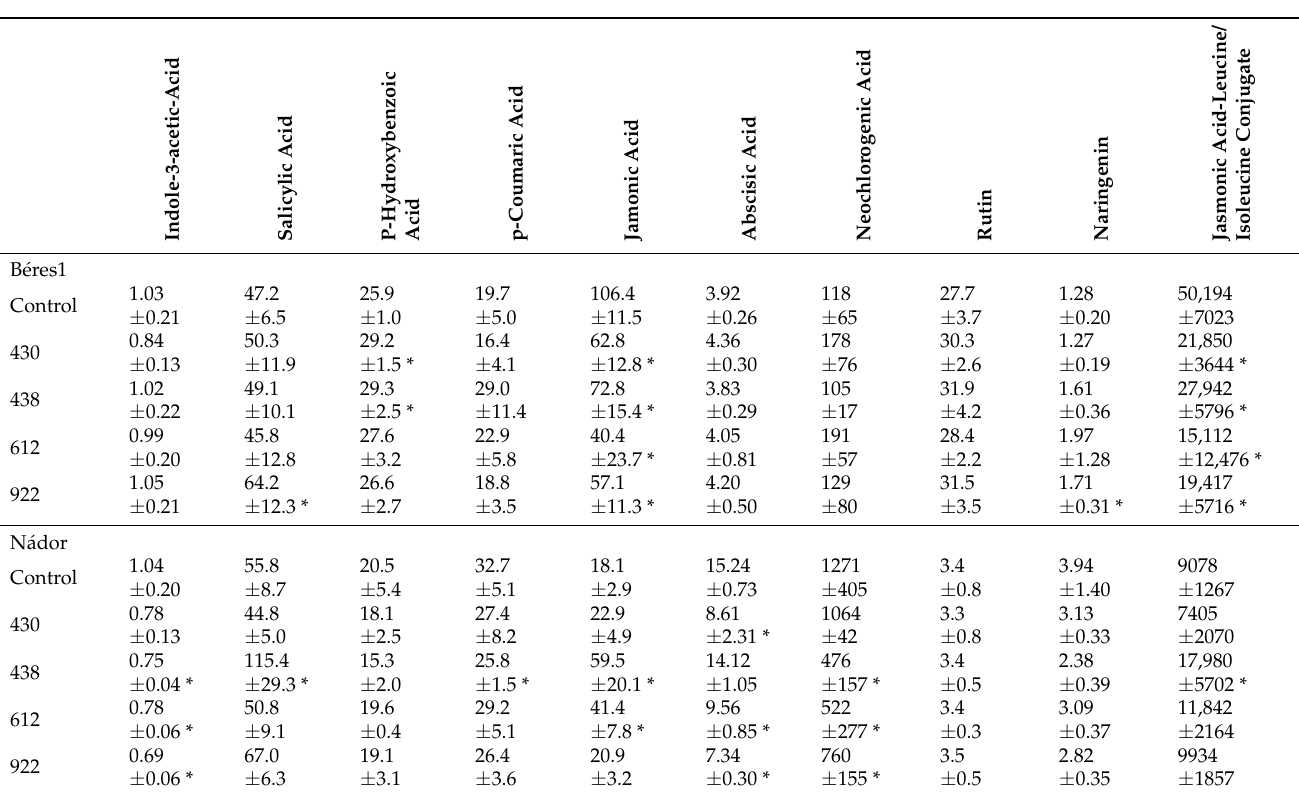
Table 4. Metabolome analysis of the leaves of wheat Mv B é res and Mv N á dor treated with different algal strains. B é res1 refers to data from the 1st experiment with Mv B é res; B é res2 and N á dor concern data from the 2nd experiments with Mv B é res and Mv N á dor, respectively. Data are in ng g − 1 Fresh weight, mean ± SD, n = 5. * represents significant differences from the control at p <